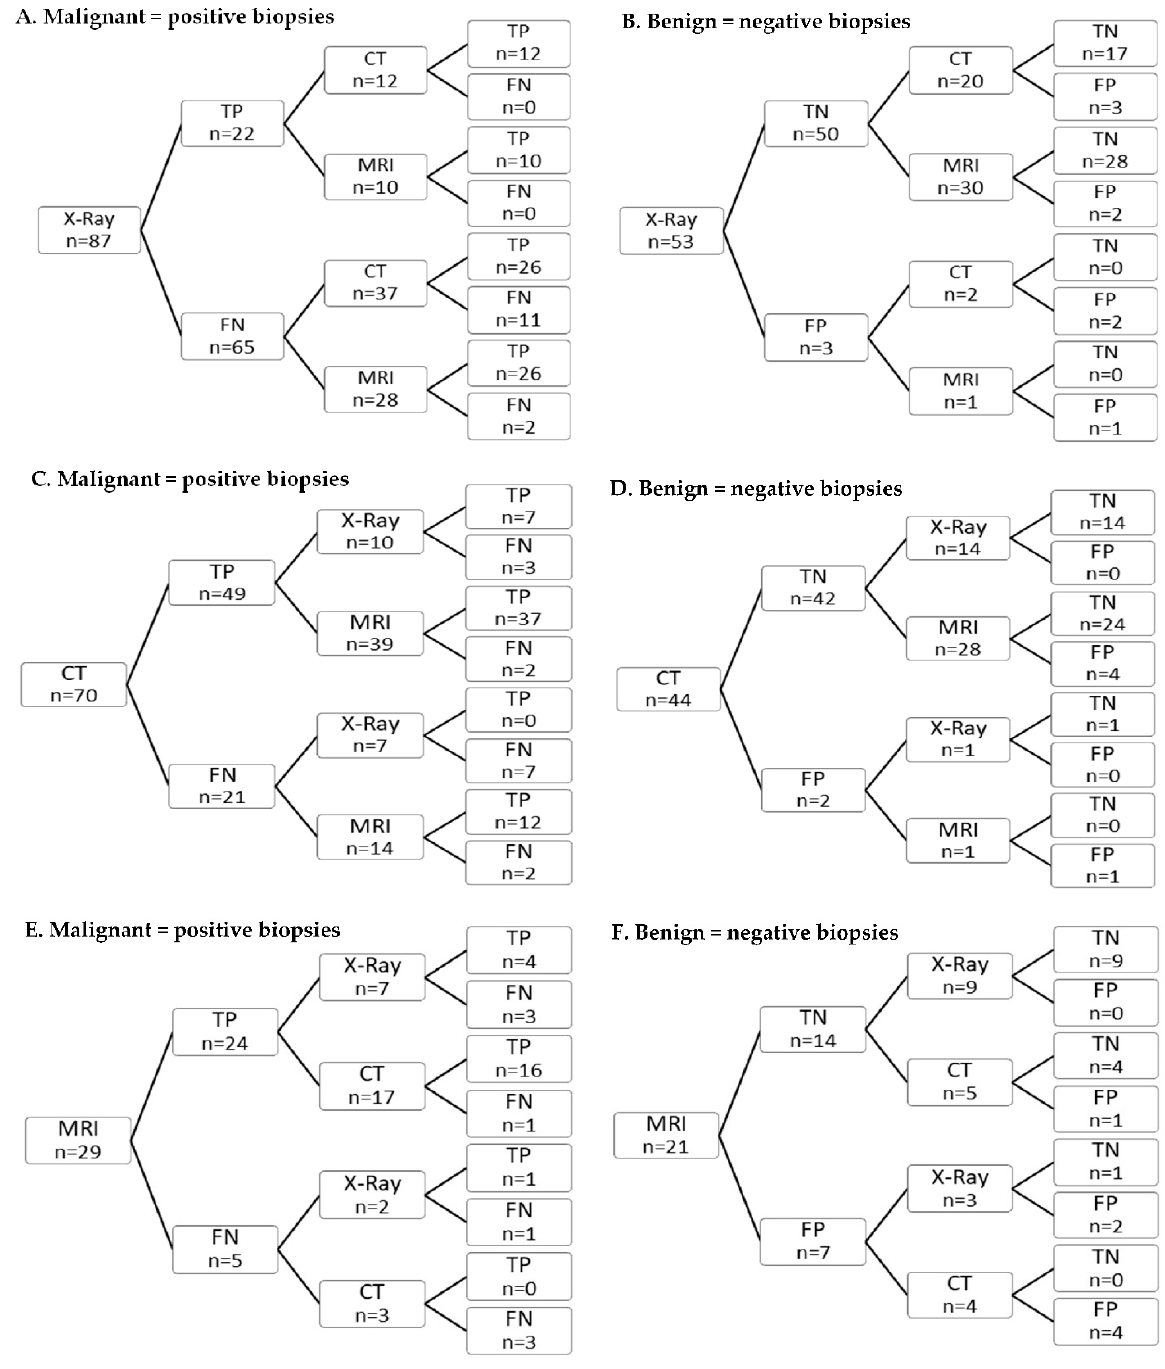
Figure 2. Sequence analyses. ( A ) Diagnostic results for malignant (positive) biopsies when X-ray is performed as the first modality (TP = true positive, FN = false negative). ( B ) Diagnostic results for benign (negative) biopsies when X-ray is performed as the first modality (TN = true negative; FP = false positive). ( C ) Diagnostic results for malignant (positive) biopsies when CT is performed as the first modality (TP = true positive, FN = false negative). ( D ) Diagnostic results for benign (negative) biopsies when CT is performed as the first modality (TN = true negative; FP = false positive). ( E ) Diagnostic results for malignant (positive) biopsies when MRI is performed as the first modality (TP = true positive, FN = false negative). ( F ) Diagnostic results for benign (negative) biopsies when MRI is performed as the first modality (TN = true negative; FP = false positive).